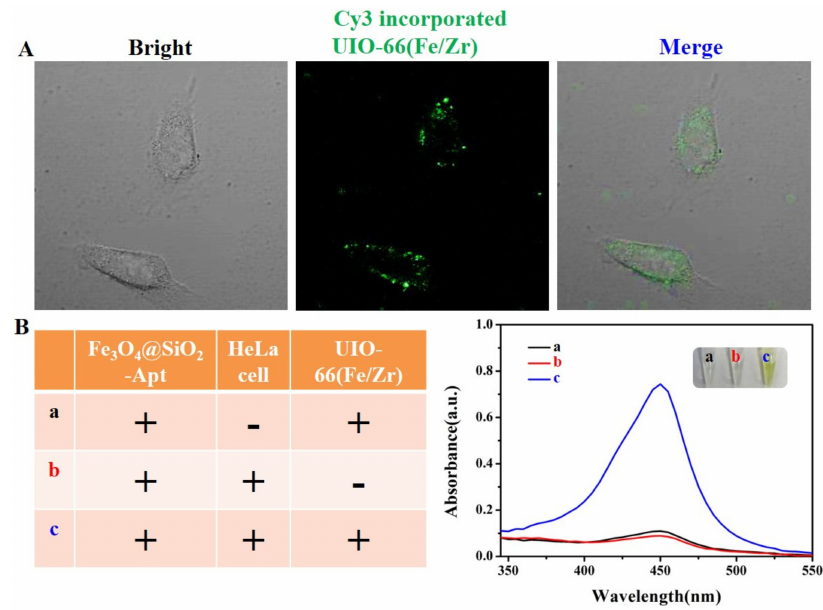
Figure 4. ( A ) Bright-field image, fluorescence image, and overlay of the fluorescence and bright-field images of HeLa cells after incubation with bare Cy3 dyes-incorporated UIO-66(Fe/Zr) NPs. ( B ) UV- vis absorbance spectra of TMB-H 2 O 2 system after different treatments. The insets show the images of their corresponding